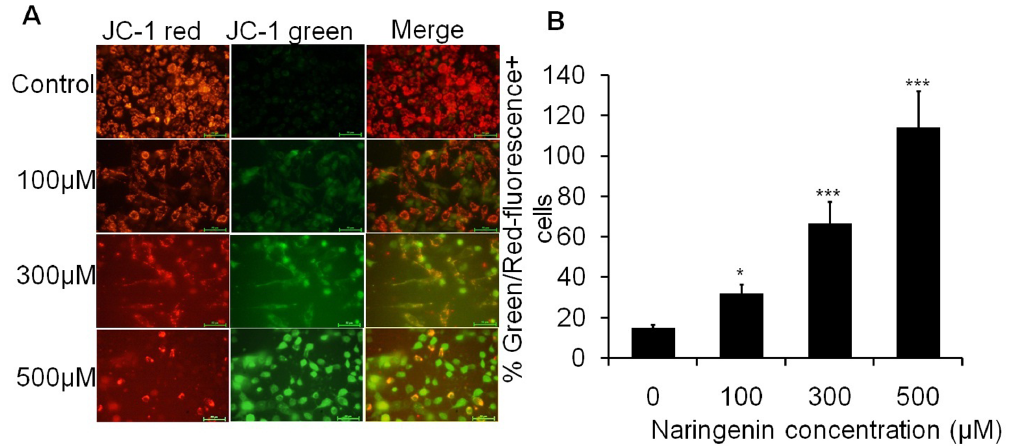
Figure 4. Fluorescence image of A431 cells stained with JC-1 after 24 h incubation with different concentrations of naringenin. (A) Photograph showing JC-1 red, JC-1 green and merge image. The JC-1 green fluorescence indicates a decrease in mitochondrial membrane potential, an early event in apoptosis. Increased concentrations of naringenin attenuated the loss of mitochondrial membrane potential. (B) Numerical data were expressed as % Green/Red fluorescence + cells which were increased with increasing doses of naringenin. Data is representative of three independent experiments and expressed as means 6 SD, *p , 0.05, **p , 0.01 and ***p , 0.001 as compared with their respective control.